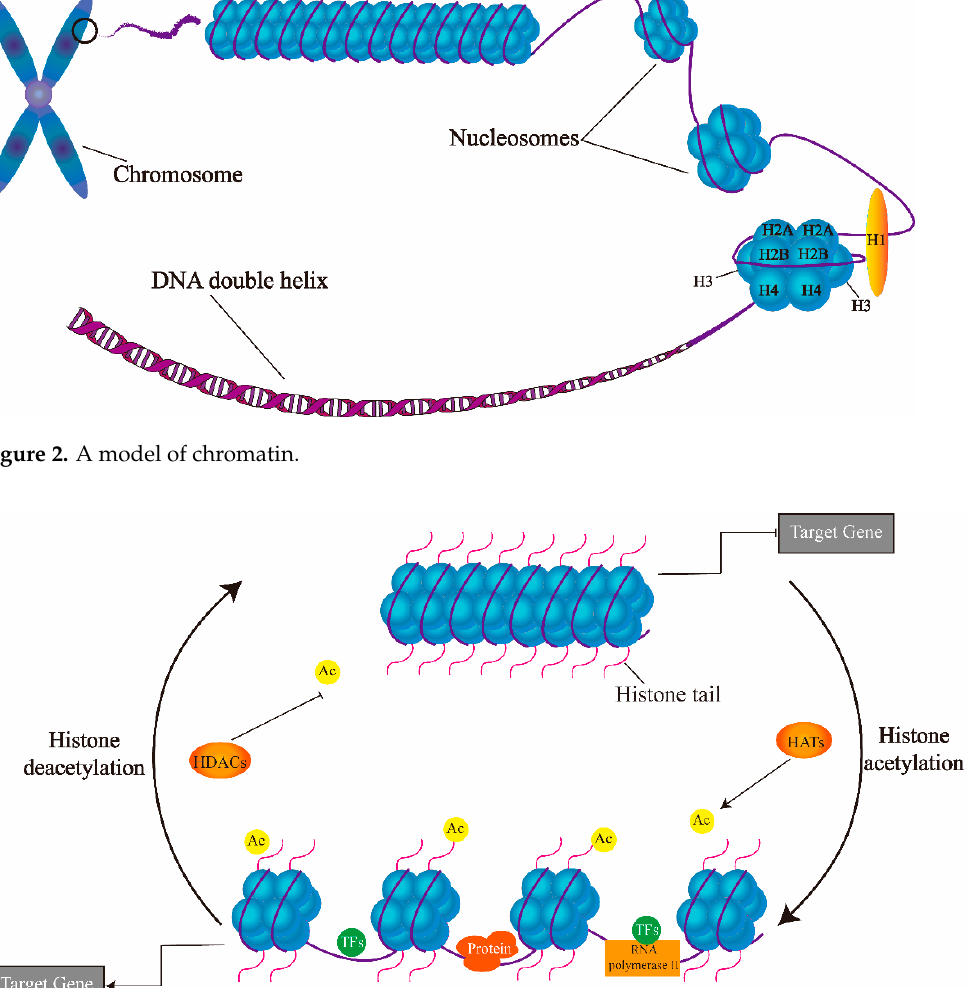
Figure 2. A model of chromatin.